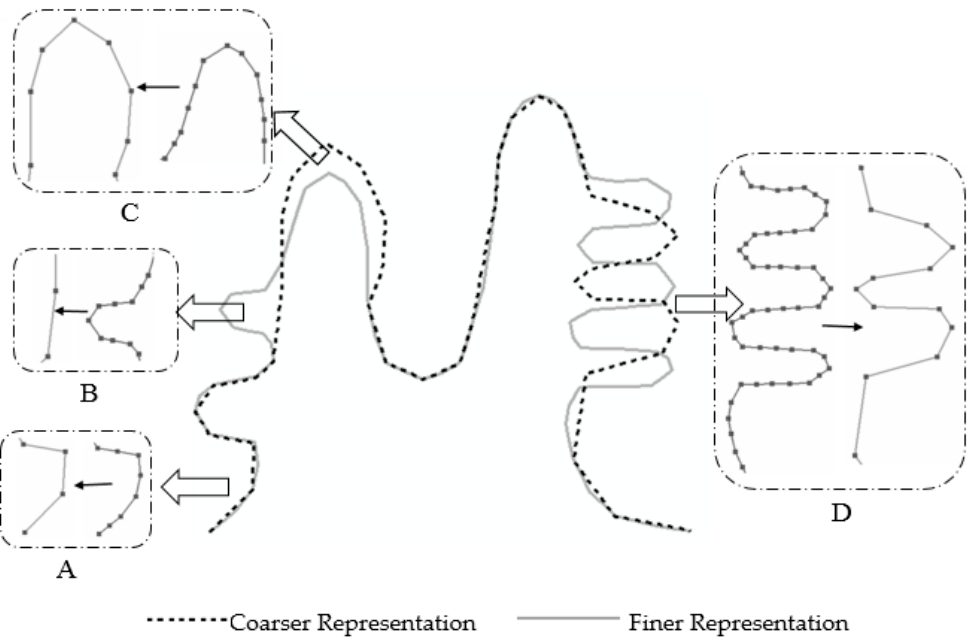
Figure 3. Applying the typical generalization operations to linear features.